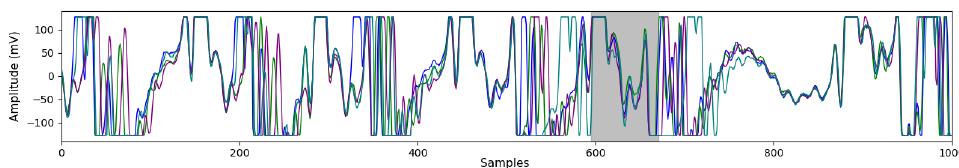
Figure 1: Pointer-Cswap 4 overlapped traces (grey color marks aligned area)